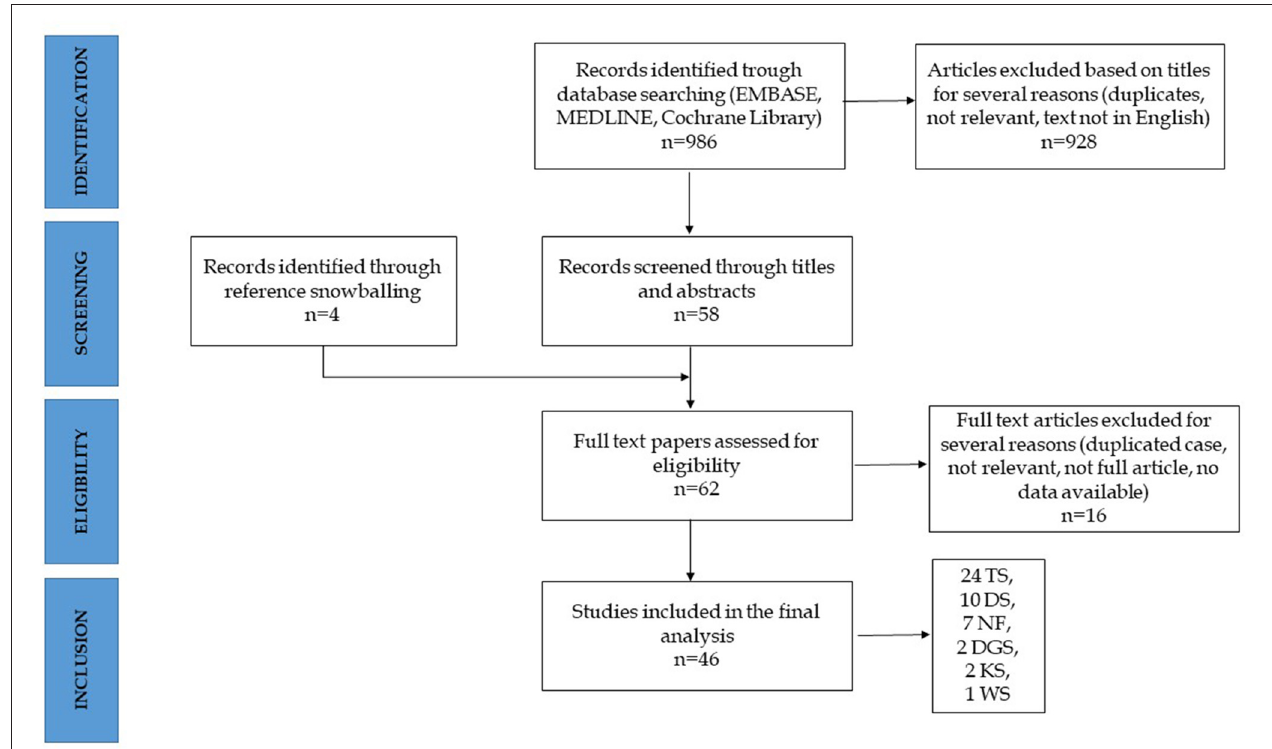
FIGURE 2 | Algorithm of inclusion. TS, Turner’s syndrome; DS, Down syndrome; NF, neurofibromatosis; DGS, DiGeorge syndrome; KS, Kabuki syndrome; WS, Williams